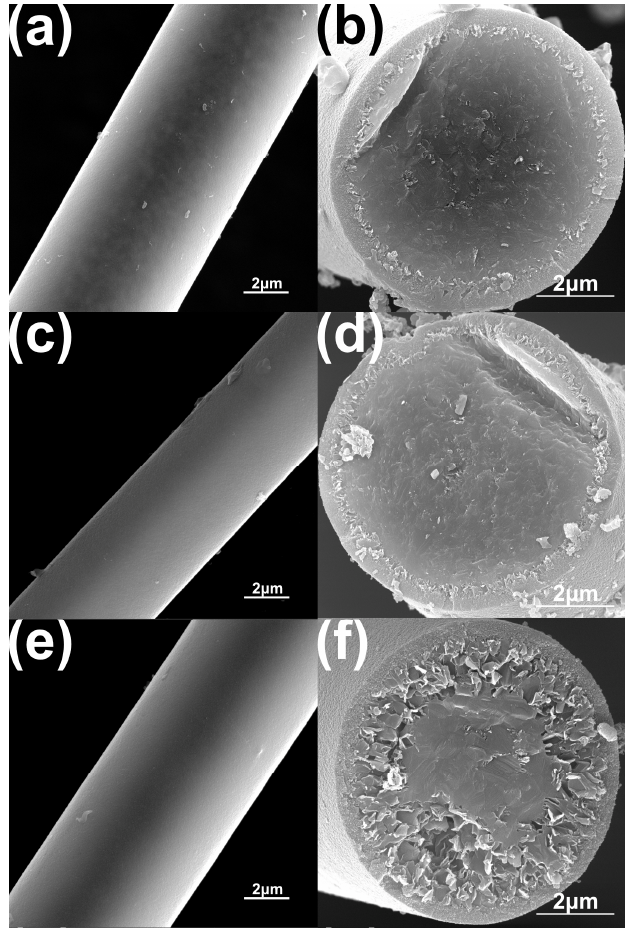
Figure 8. SEM images of the surface ( a , c , e ) and cross–section ( b , d , f ) of the Si–C–Ti–B fiber after heat treatment for 1 h under argon atmosphere at 1900 °C ( a , b ), 2000 °C ( c , d ), and 2100 °C ( e , f ), respec- tively.